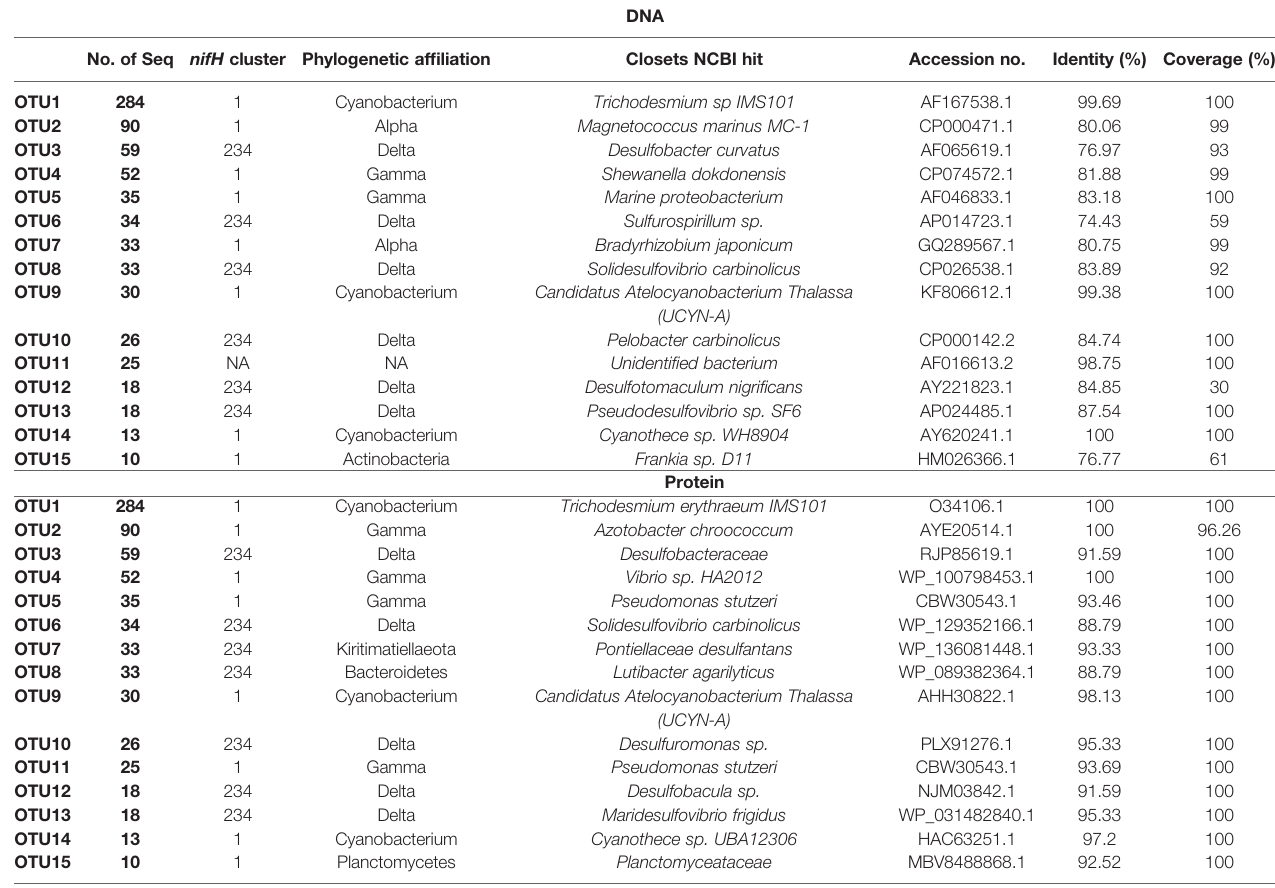
TABLE 2 | OTU identities of the 15 (out of 83) most abundant OTUs (>10